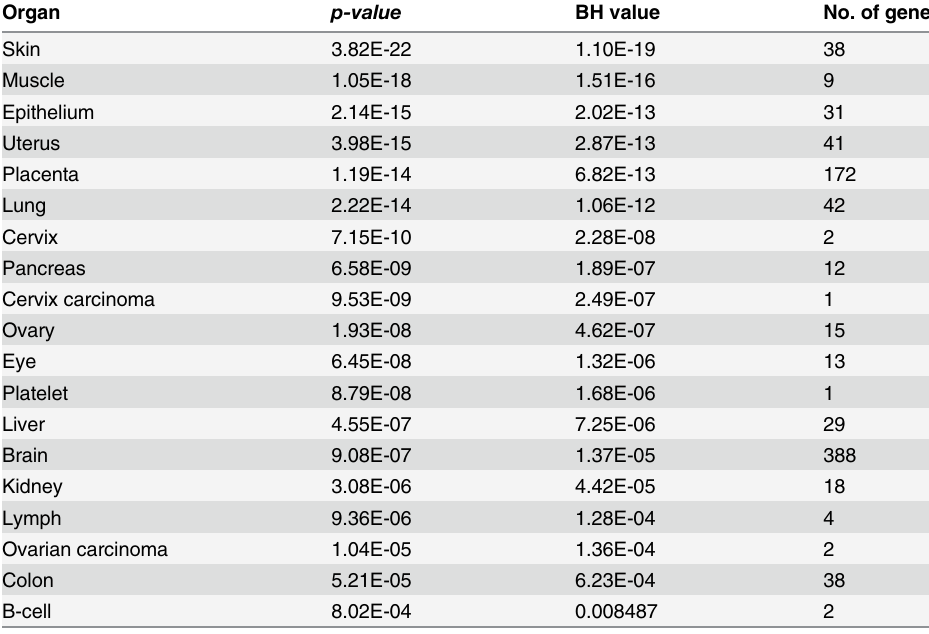
Table 4. Tissue-specific genes expressed in both AFS and amniocytes.